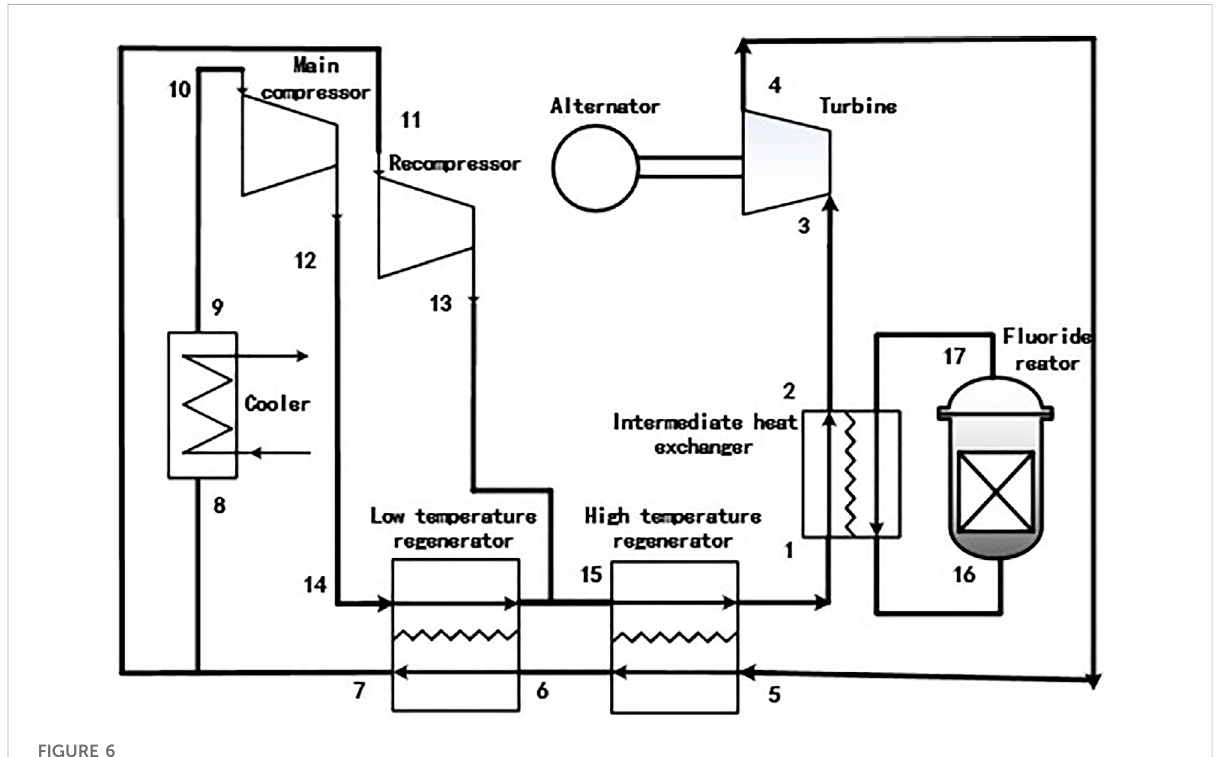
FIGURE 6 Flow chart of the recompression Brayton